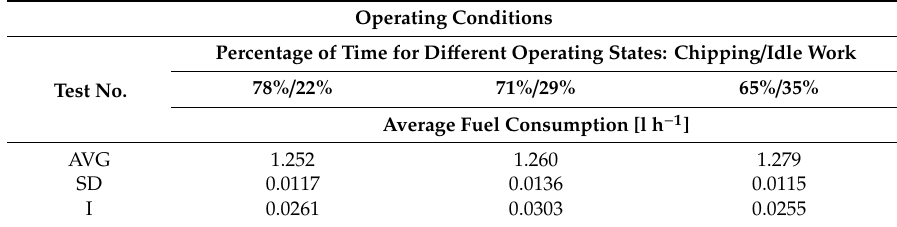
Table 5. The results of fuel consumption of the cylindrical wood chipper with injector fuel supply system (B) in periodically-variable exploitation conditions (3); AVG–arithmetic average, SD–standard deviation of the mean, I–incertitude limits using the Student’s t distribution for a 95% confidence level.